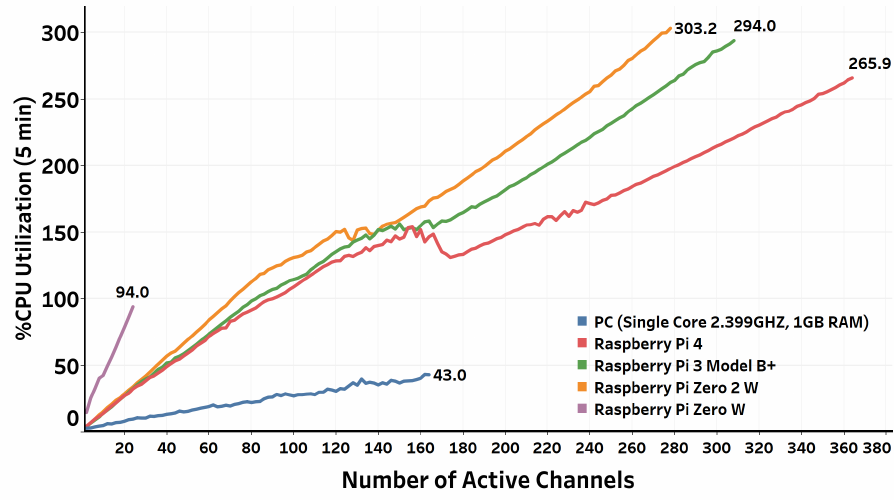
Figure 10. Relation between the number of active channels and the CPU utilization